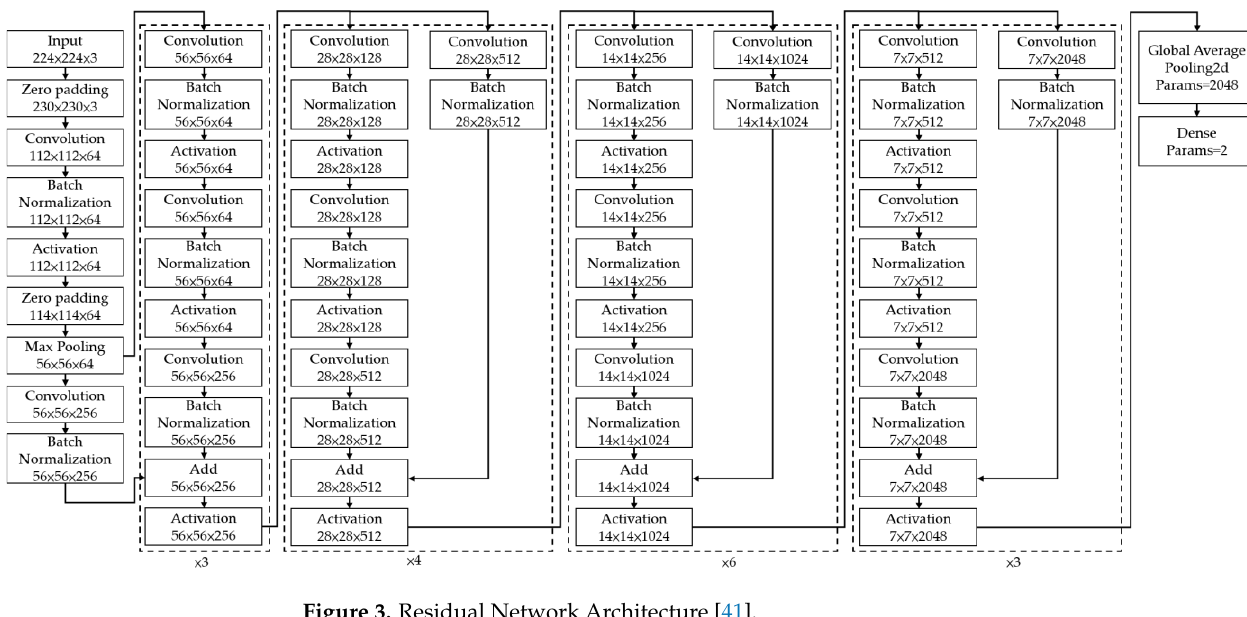
Figure 2. Residual Block [41].